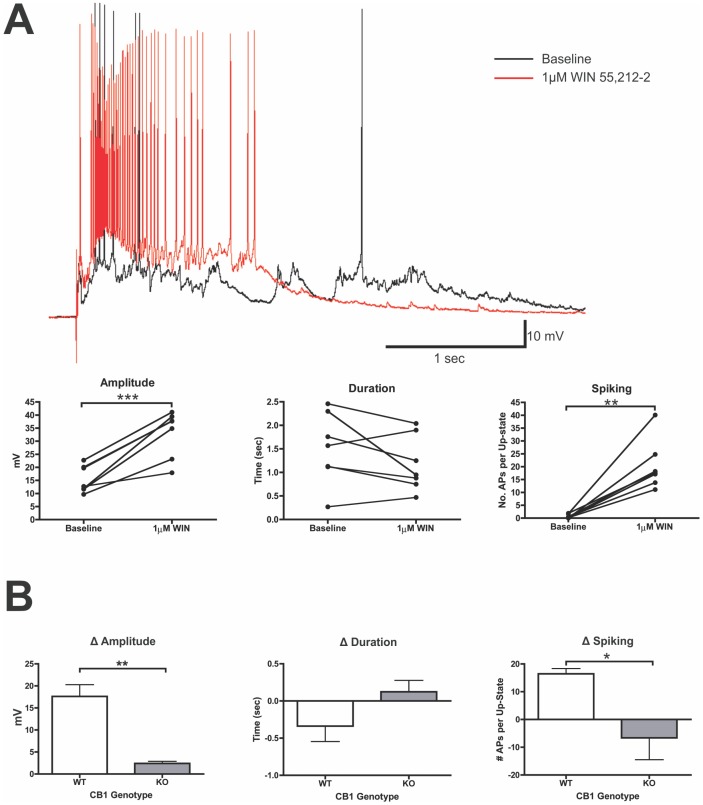
The CB1 agonist WIN 55,212-2 enhances up-state amplitude and spiking.A, example traces from the same neuron before and after application of WIN (1 µM) and summary data from these experiments. In graphs, connected points represent data from the same neuron. B, comparison of the change in up-state parameters following WIN treatment in wt and CB1 KO cultures. Bars represent mean ± SEM of difference scores for each measure of up-states (N = 7 cells). Symbols: *p<0.05, **p<0.01, and ***p<0.001.